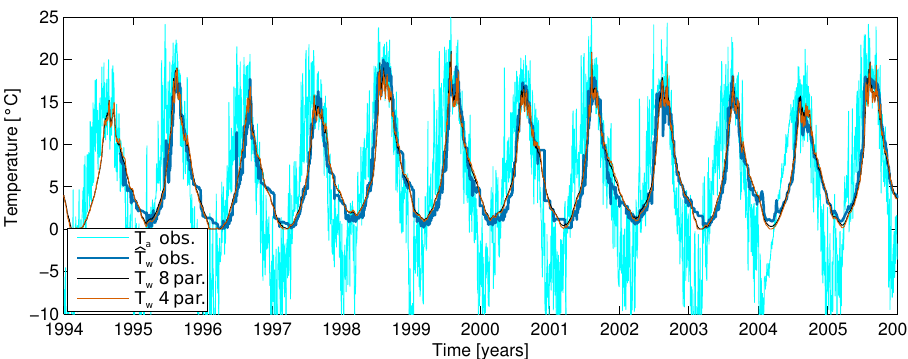
Fig. 8. Evolution of the dimensionless depth δ over the period 2003-2011: comparison between results for the full 8- and simplified 4- parameter versions of the model obtained from NDBC and GLERL simulations. a) Comparison of observed water temperature time series during the period 2003-2011 for the NDBC and GLERL dataset, respectively. b) Evolution of the dimensionless depth δ over the period 2003-2011 for the full 8- and simplified 4-parameter versions of the model (NDBC and GLERL simulations).